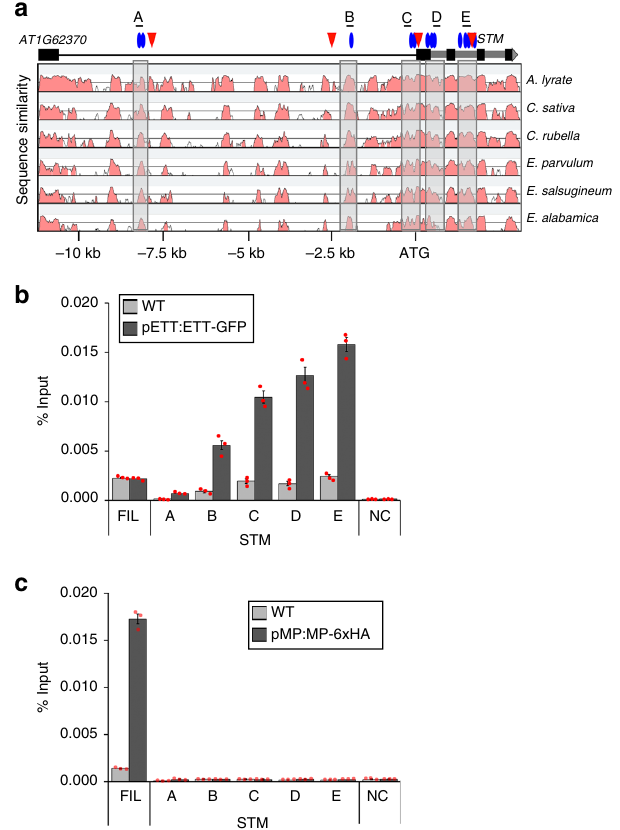
Fig. 4 ETT binds the STM locus in vivo. a Phylogenetic shadowing of the STM locus. Top: fi ve conserved domains (A – E) tested. Below: ARF binding sites and locus architecture. Blue ovals, conserved Auxin Response Factor core elements (TGTC); red triangles, ETT binding sites (TGTCAT); 36 black boxes, exons; grey boxes, introns; black line, upstream intergenic region. Bottom: mVista plot. Grey shaded areas correspond to conserved regions tested. b , c Chromatin immunoprecipitation (ChIP) to test ETT ( b ) or MP ( c ) binding to conserved regions of the STM locus. TA3 served as negative control. An MP-bound region of the FIL locus 9 served as positive control for MP ChIP ( c ) and as negative control for ETT ChIP ( b ). ChIP was performed